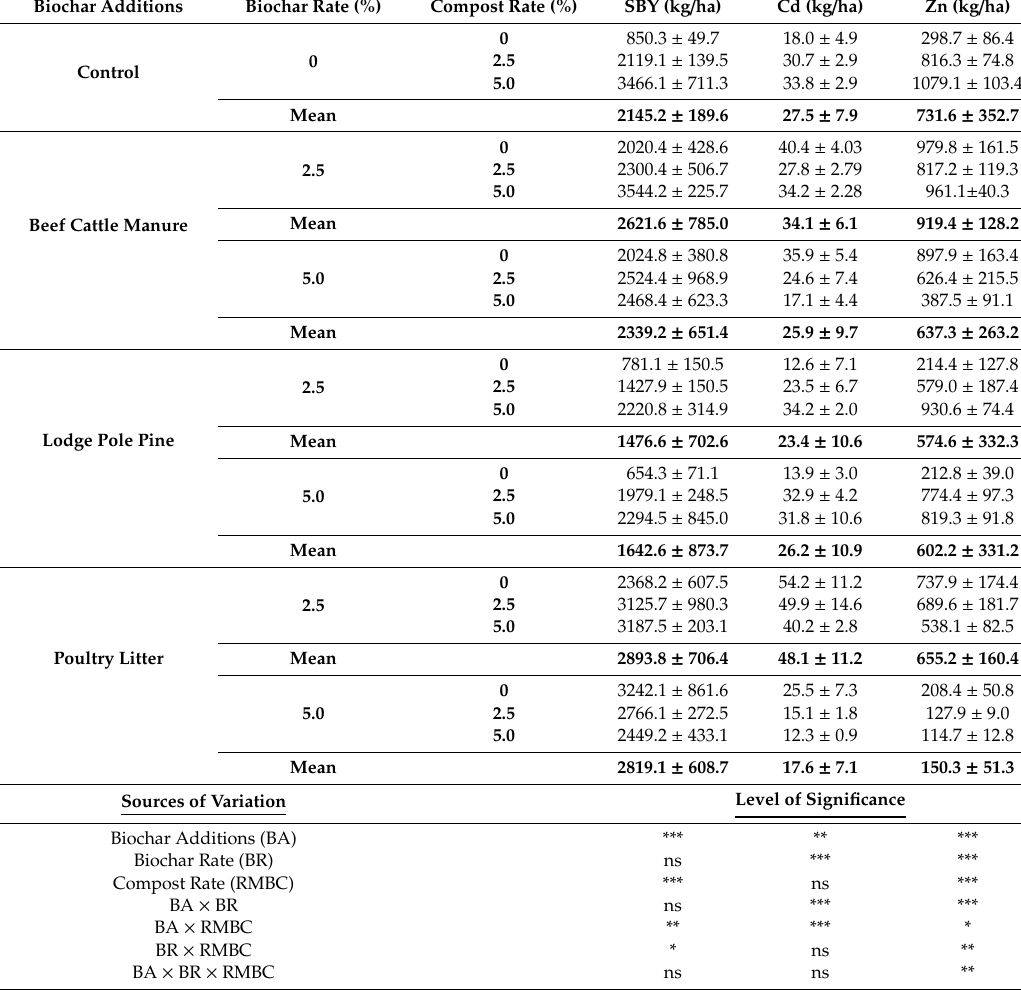
Table 5. Average shoots biomass (SBY) and uptake of Cd and Zn in shoot biomass of